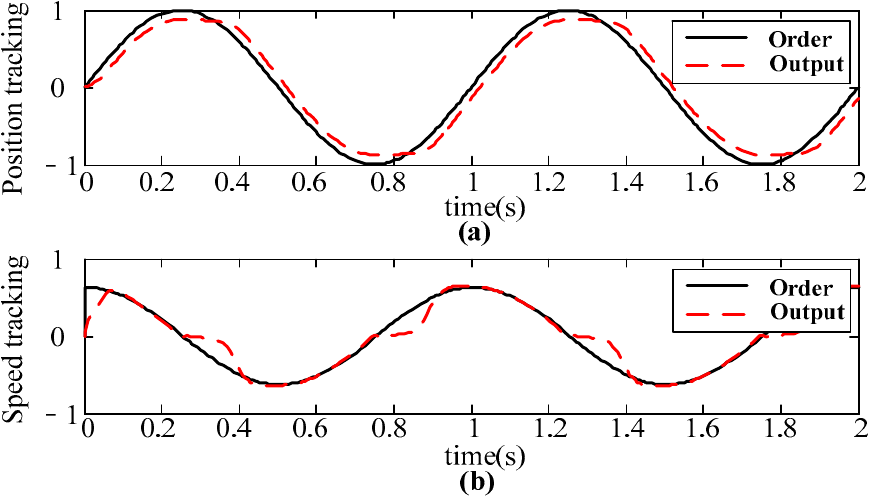
Figure 6. Simulation results of position and speed tracking. Notes: ( a ) Position tracking; ( b ) Speed tracking.